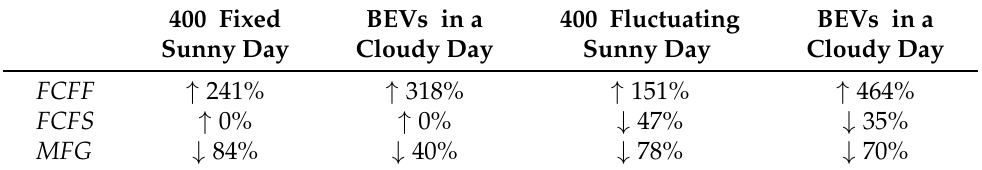
Table 4. Standard deviation increase/reduction of SOCs’